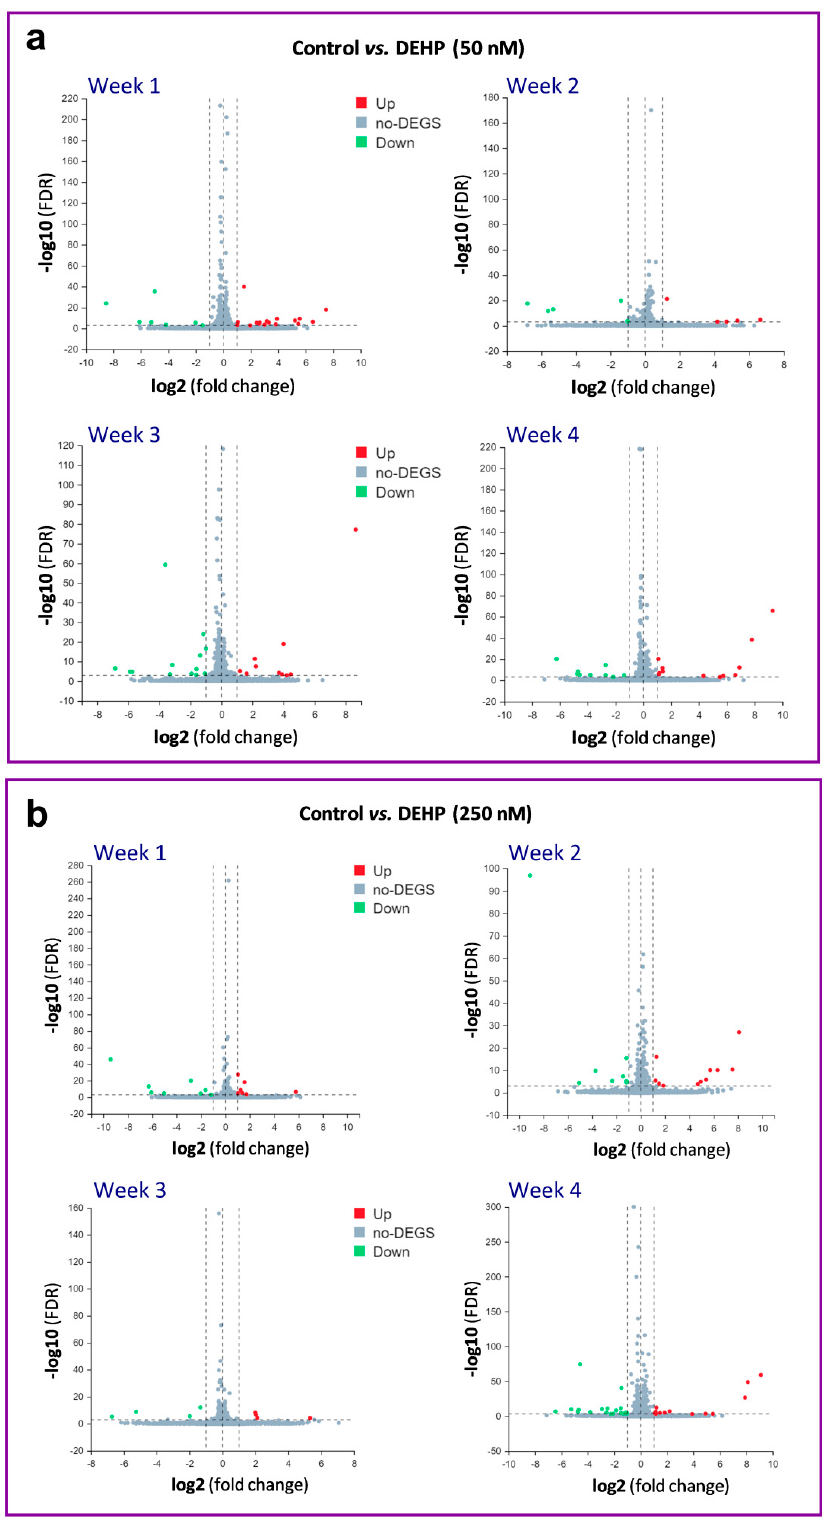
Figure 3. Volcano scatter plots of mRNA expression in DEHP-exposed HGrC1 cells. ( a ) DEHP50 and ( b ) DEHP250 compared to the non-treated control. The X-axis represents the fold change of the difference after conversion to log2, and the Y-axis represents the significance value (false discovery rate, FDR) after conversion to − log10. In each plot, significantly upregulated genes are highlighted in red, and downregulated genes are highlighted in green. Non-significant findings are represented as grey dots.